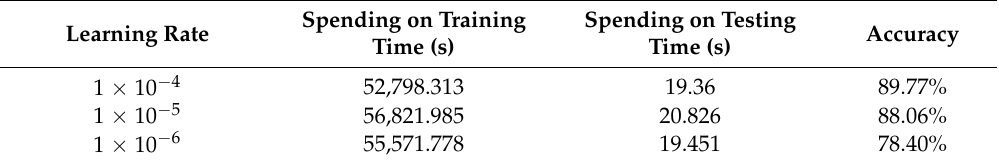
Table 1. Time for deep learning of training and testing data